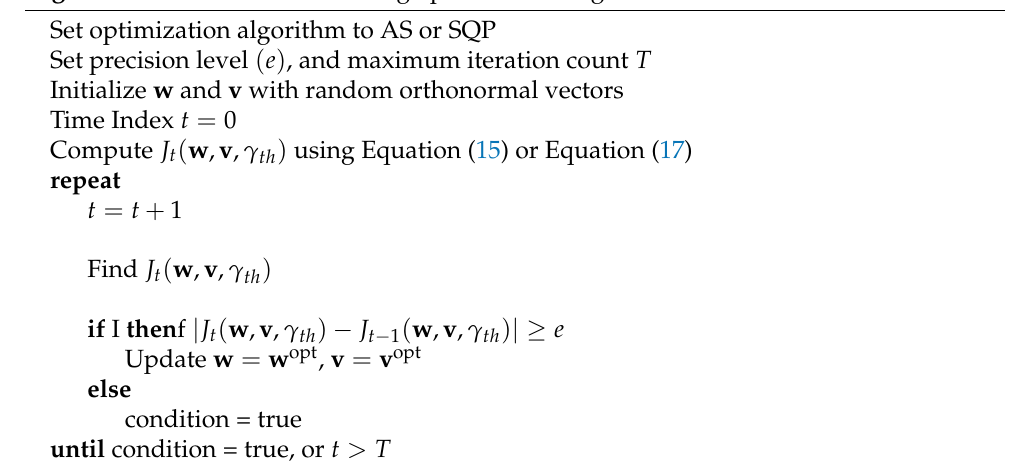
Algorithm 1 NOMA-BeamformingOptimization Algorithm.